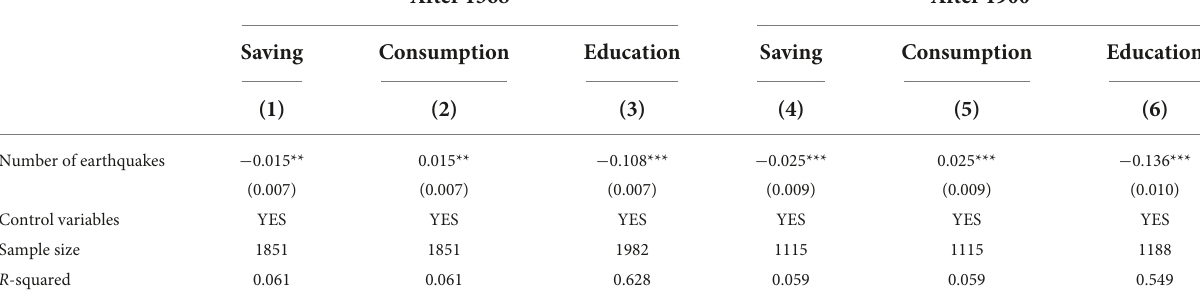
TABLE 7 Robustness teat: earthquake samples over periods of different